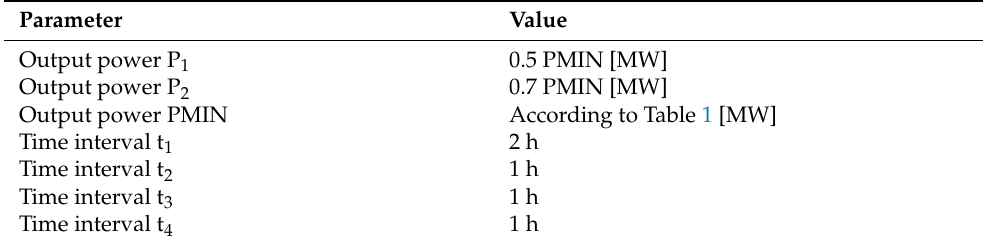
Table 2. Parameters of the modelled start-up characteristic.